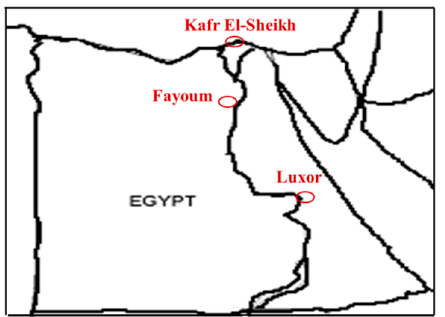
Figure 1. Location of the Kafr El-Sheikh, Fayoum and Luxor governorates in Egypt. Upper Egypt was represented by 12 villages located in the Luxor governorate, Middle Egypt was represented by 13 villages located in the Fayoum governorate and Delta Egypt was represented by 13 villages located in the Kafr El-Sheikh governorate, as shown in Table 1. The survey was carried out by the Animal Production Research Institute (APRI) team by organizing visits to smallholders of domestic Egyptian geese within these three governorates. Table 1. Number of studied birds, villages and their latitude and longitude in each governorate. Governorate No. Villages No. Birds